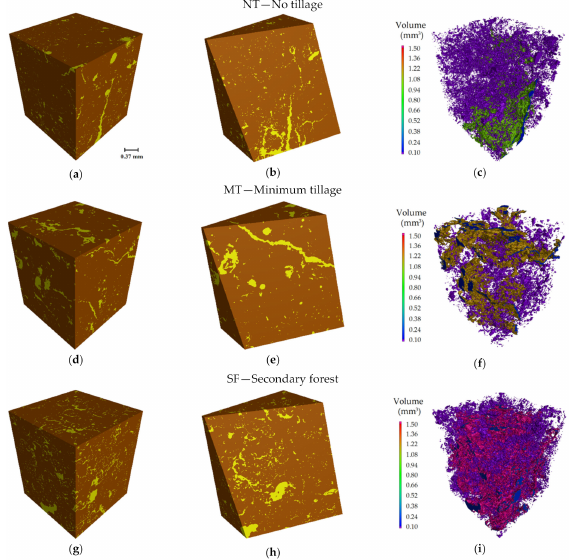
Figure 1. ( a , d , g ) Region of interest (ROI) selected in the three dimensional (3D) image of one out of six aggregates from no tillage (NT), minimum tillage (MT), and secondary forest (SF), where yellow represents the pore phase and brown represents the solid matrix phase. ( b , e , h ) Diagonal cross section in the selected ROIs. ( c , f , i ) Renderings in 3D of the segmented pore phase from the selected ROIs, where the different colors represent pore volume variation.